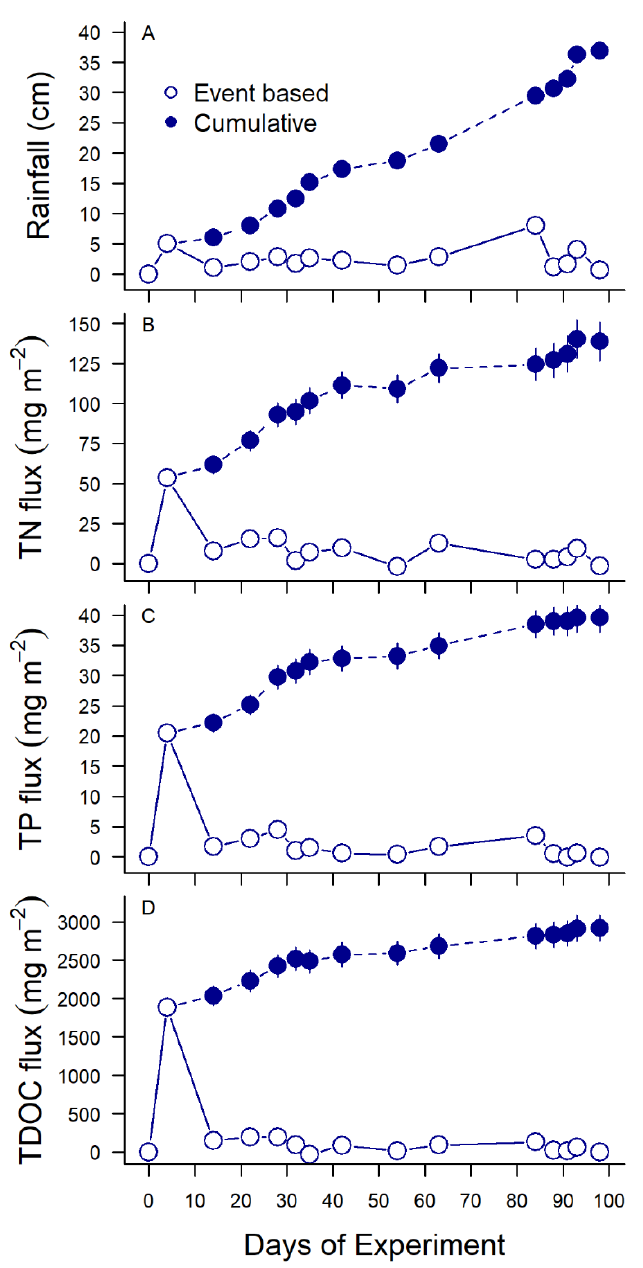
Figure 4. Mean (± SE) rainfall ( A ) and TN ( B ), TP ( C ), and TDOC ( D ) mesocosm export occurring during 15 storms between December and March. Open circles represent individual storm event means and closed circles track the cumulative rainfall and nutrient export over time. Table 4. Effects of P enrichment and day on vegetated mesocosm TKN, TP and TDOC export during winter storm events. F values and associated P values are based on linear mixed-effect models that incorporated random effects to account for repeated measures within each mesocosm.